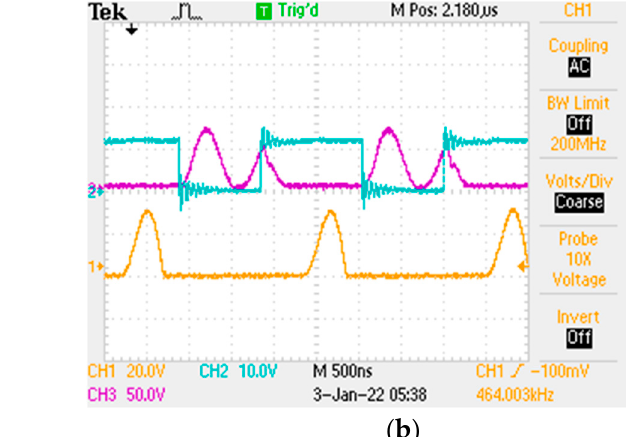
Figure 9. Waveform of the class-E 2 with 8-plate multi-resonant coupling (blue: gate signal, purple: voltage across MOSFET, orange: voltage across diode) ( a ) without misalignment and ( b ) with 10% misalignment.